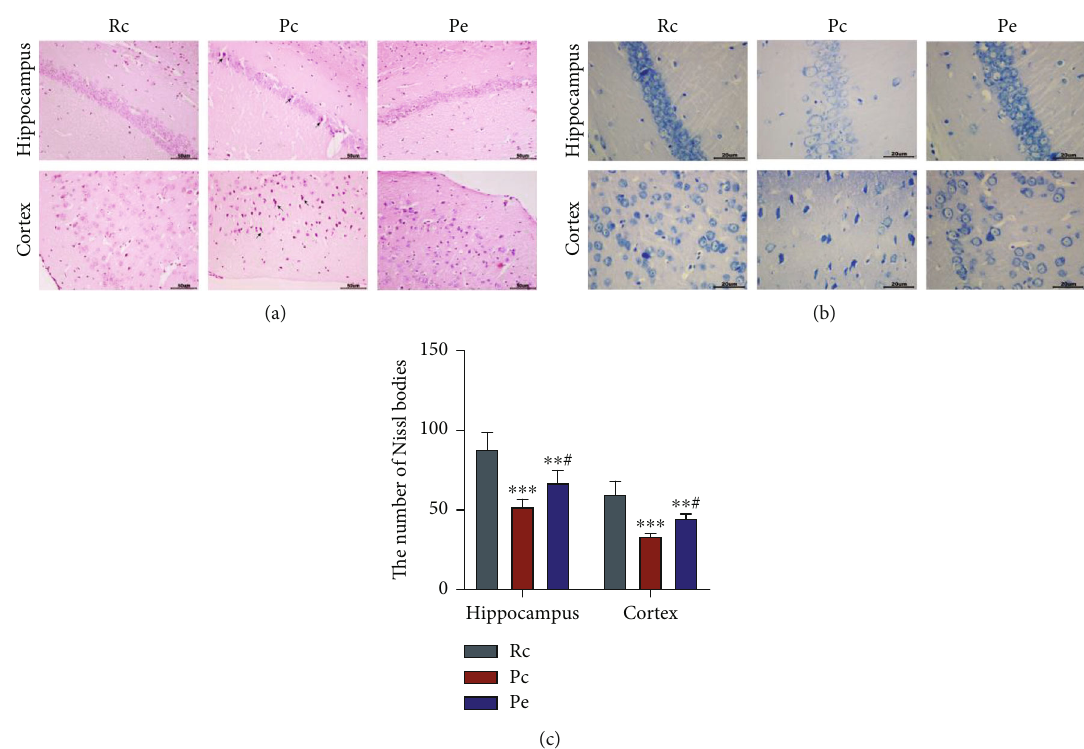
Figure 4: EA alleviated neuropathological injury of brain tissue in SAMP8 mice: (a) HE staining, scale bars = 50 μ m; (b) Nissl staining, scale bars = 20 μ m; (c) the number of Nissl bodies in the hippocampus and cortex. Data are expressed as the mean ± SD ( n = 4 in each group). ∗∗ P < 0 : 01 and ∗∗∗ P < 0 : 001 versus the Rc group; # P < 0 : 05 versus the Pc group.